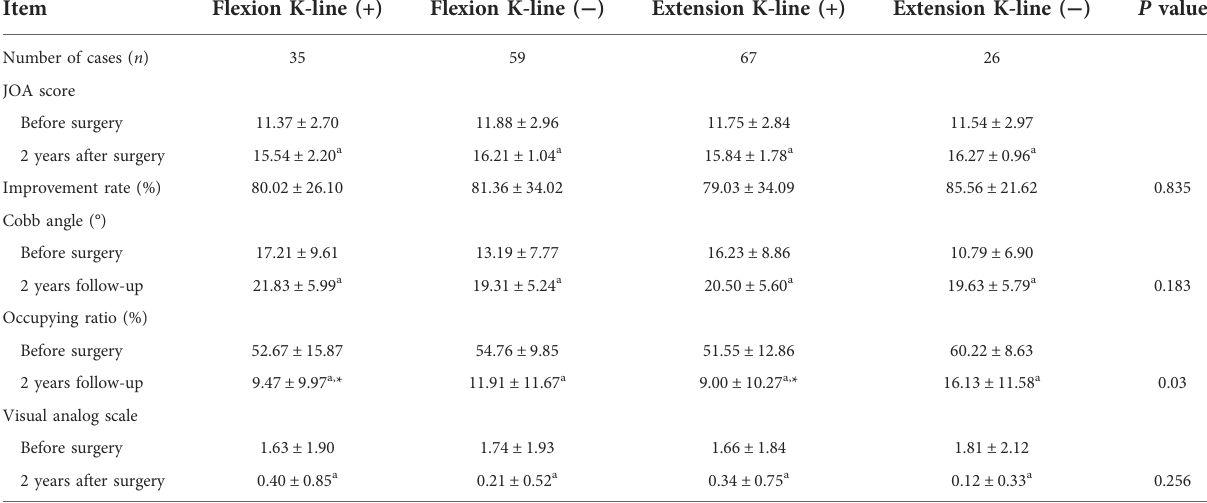
TABLE 3 Clinical data according to the K-line classi fi cation in the cervical dynamic